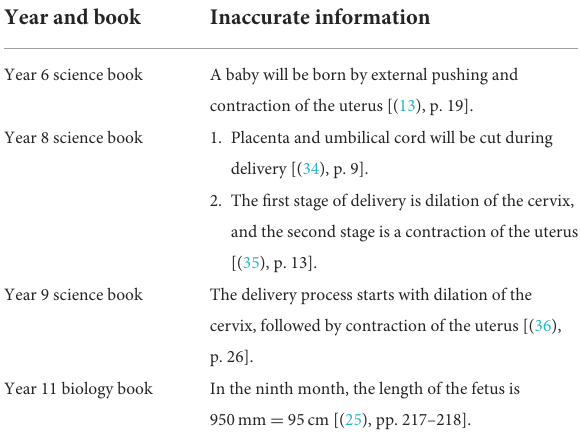
TABLE 3 Some inaccurate information about pregnancy and